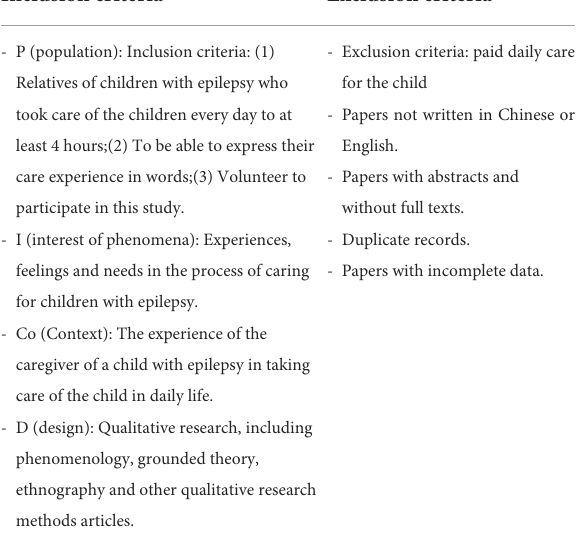
TABLE 1 Review inclusion and exclusion